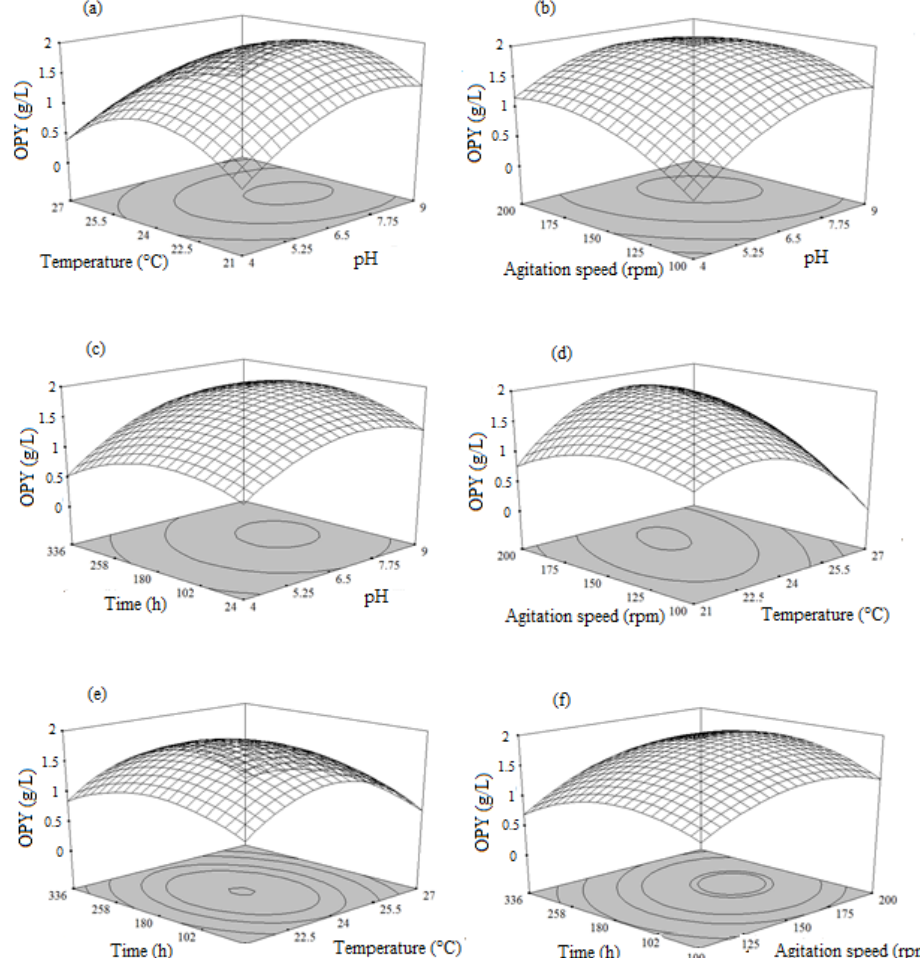
Figure 1. Response surface plots showing the influence of the process variables on the orange pigment yield (OPY): ( a ) Interaction between temperature and pH; ( b ) Interaction between agitation speed and pH; ( c ) Interaction between time and pH; ( d ) Interaction between agitation speed and temperature; ( e ) Interaction between time and temperature; ( f ) Interaction between time and agitation